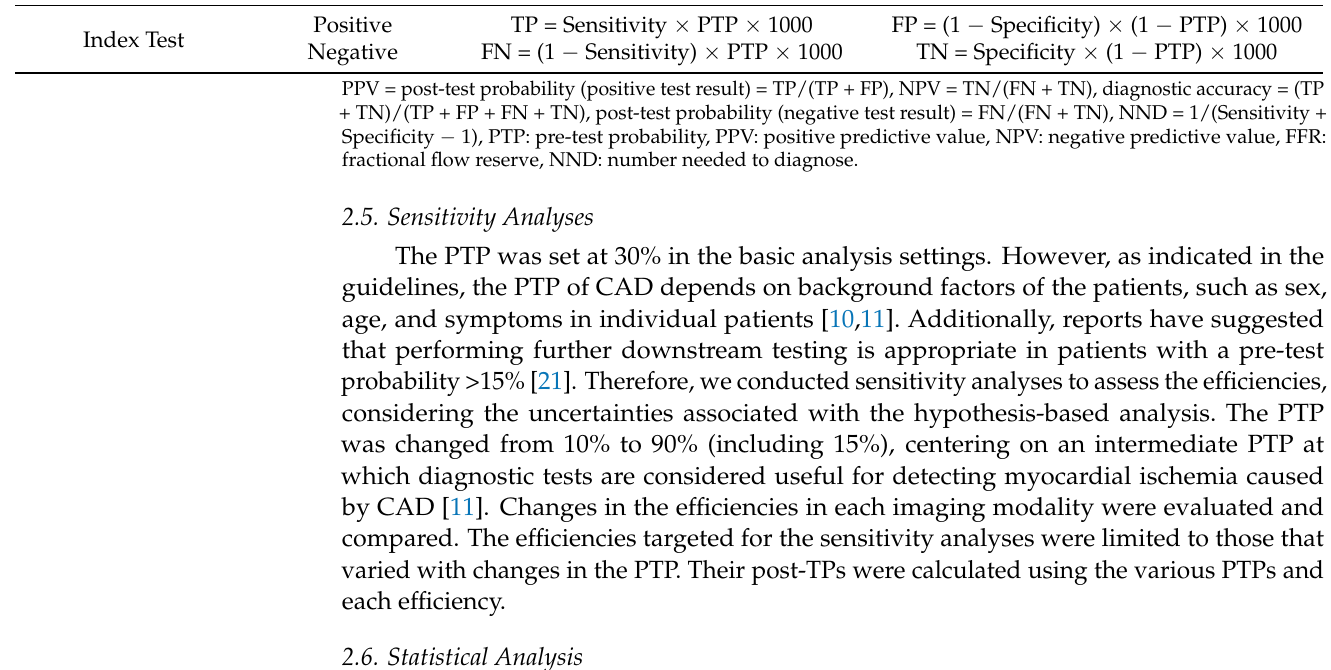
Figure 1. Decision tree model. CMRI: cardiac magnetic resonance imaging, SPECT: single-photon emission computed tomography, SE: stress echocardiography, FFRCT: fractional flow reserve derived from coronary computed tomography angiography, PET: positron emission computed tomography. Table 1. Calculation method for efficiencies per 1000 patients.